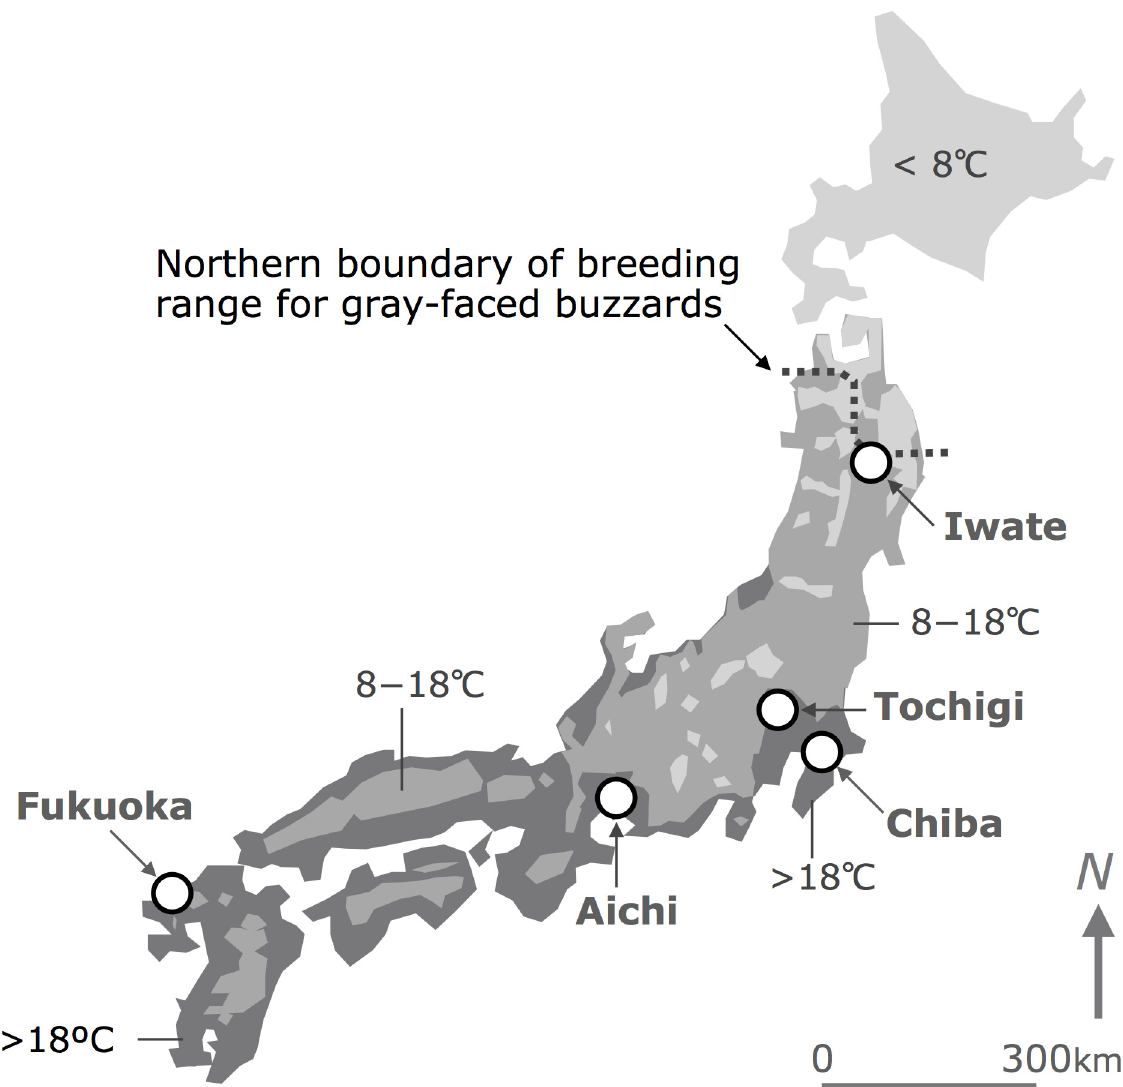
Fig 1. Locations of five study-sites. Average temperatures (°C) in May of 2010 are shown. We draw the map based on a map provided by Japanese Meteorological Agency